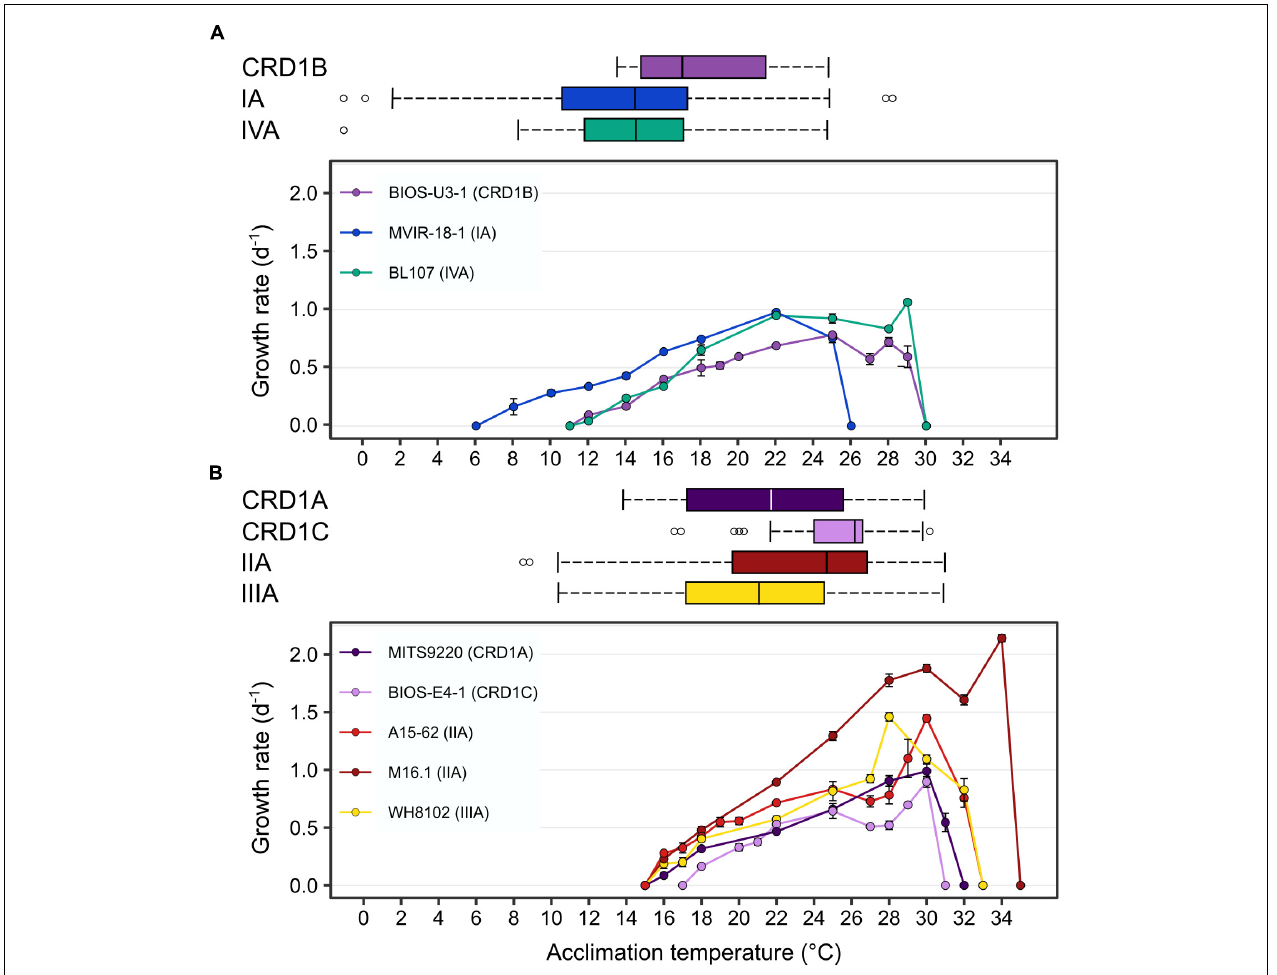
FIGURE 1 | Fundamental thermal niches of CRD1 vs. clade I, II, III, and IV strains and environmental realized niches of the corresponding ESTUs. (A) CRD1-B strain BIOS-U3-1 vs. cold thermotypes. (B) CRD1-A strain MITS9220 and the CRD1-C strain BIOS-E4-1 vs. warm thermotypes. The insert indicates the strain names and their corresponding ESTU ( sensu Farrant et al., 2016) between brackets. Each data point is the average of at least 3 biological replicates. Environmental realized niches are indicated as horizontal boxplots for each ESTU above each graph with the whiskers corresponding to 1.5-fold the interquartile range and outliers being plotted as individual